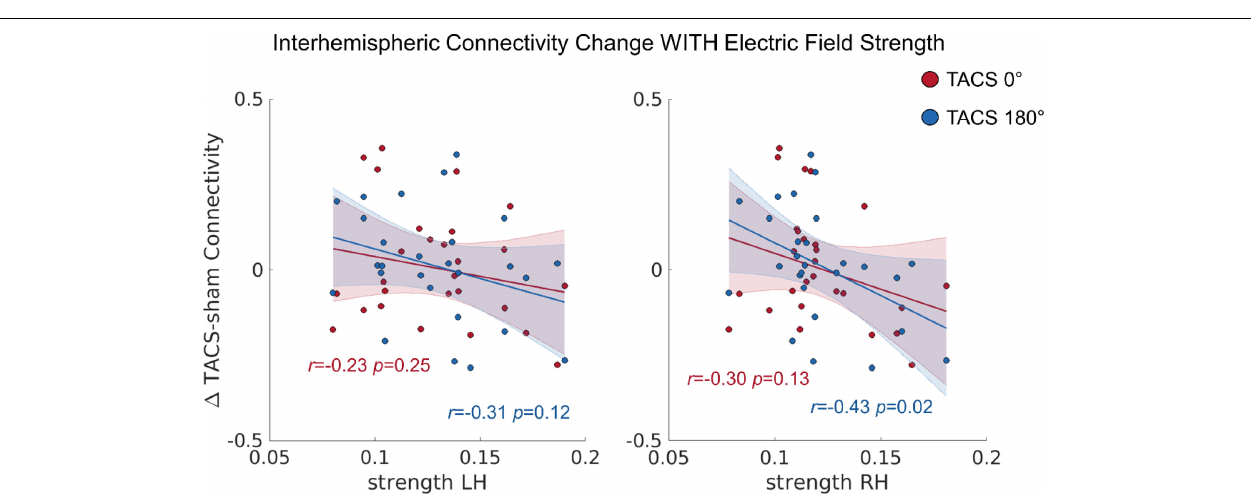
FIGURE 5 | The correlation between the tACS induced connectivity changes and the individual electric field strength in LH and RH. r = Pearson correlation. Error ribbon represents the 95% confidence interval obtained for the fit of a robust linear